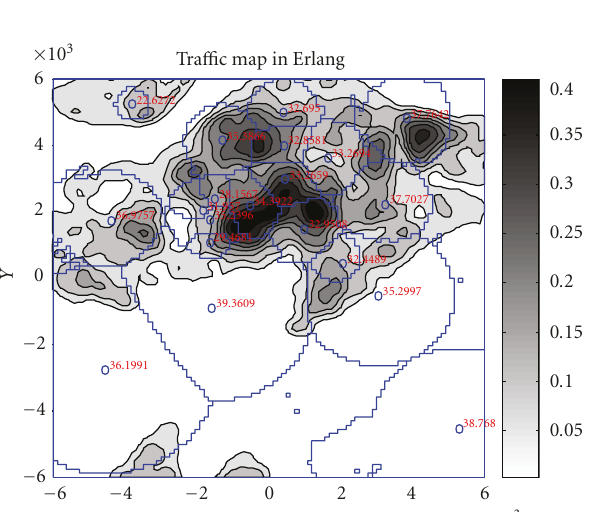
Figure 18: Tra ffi c density map.